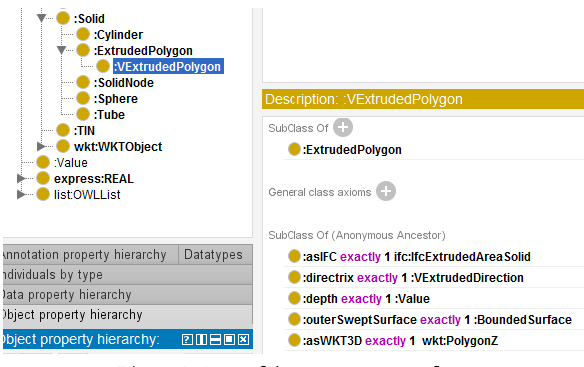
Figure 3. Part of the geometry ontology